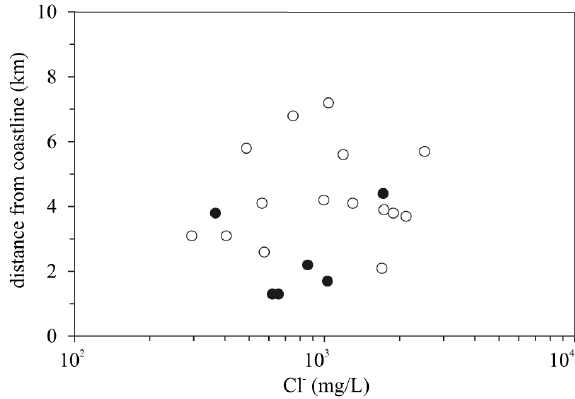
Fig. 7. Binary plot of Cl vs. distance from coastline.